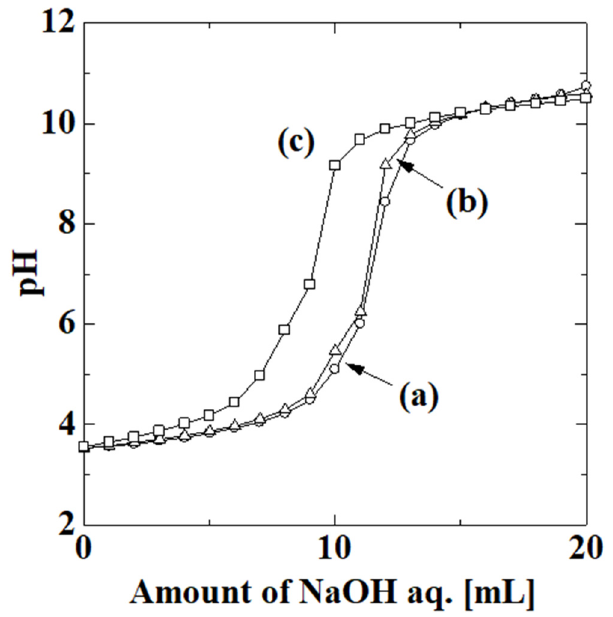
Figure 5. Titration curves of for ( a , ○ ) membrane-free system, ( b , Δ ) uncoated alumina support, and ( c , (cid:3) ) PAA-coated alumina membrane obtained after the fourth step with four polymerizations.